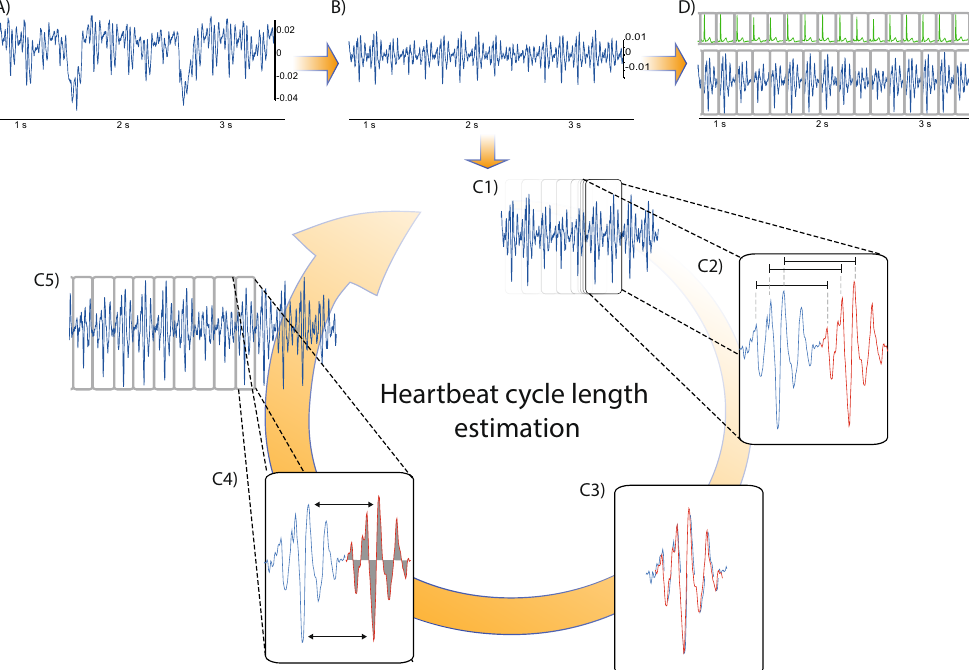
Figure 8. Processing the genuine BCG signal, identifying and analysing the heartbeats and correlation with a simultaneous recorded ECG. ( A ) Genuine BCG signal shows a superposition of slow oscillating respiration work at 5–10 seconds, high but smaller oscillating cardiac activity as well as deterioration by artefacts like body movement ( B ) After filtering the respiration and movement artefacts, the mechanical vibration of cardiac activity becomes visible; (C1) A sliding window of interest moves forward on the signal and identifies artefacts and marks corrupted sequences or continues for further analysis. (C2) By comparison of repeating amplitude sequences, consecutive heartbeats (blue and red line) are identified in a frequency range of interest; (C3) Three local interval estimators compare the two identified BCG patterns for their specific sequence, height, area under the curve and cycle length. (C4) Out of this information an individual cycle length and QI of each captured beat is estimated. The QI shows the comparability to the previous identified beats and allows to filter artefacts; (C5) Estimated parameters of each identified heartbeat are stored for further analysis. ( D ) Heartbeat cycle length is correlated for this study with a simultaneously recorded